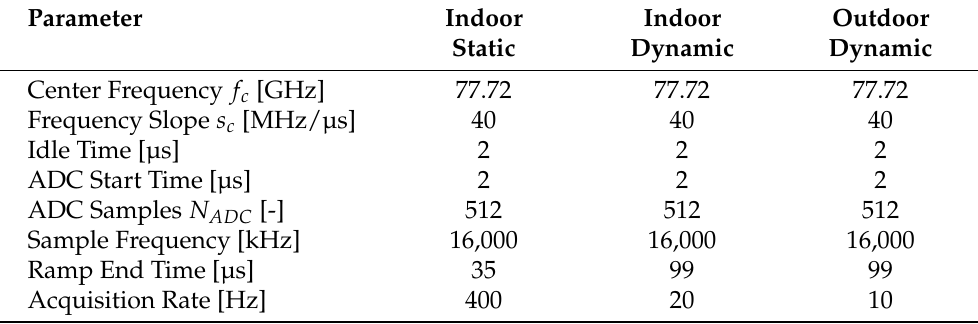
Table 2. Parameters for the